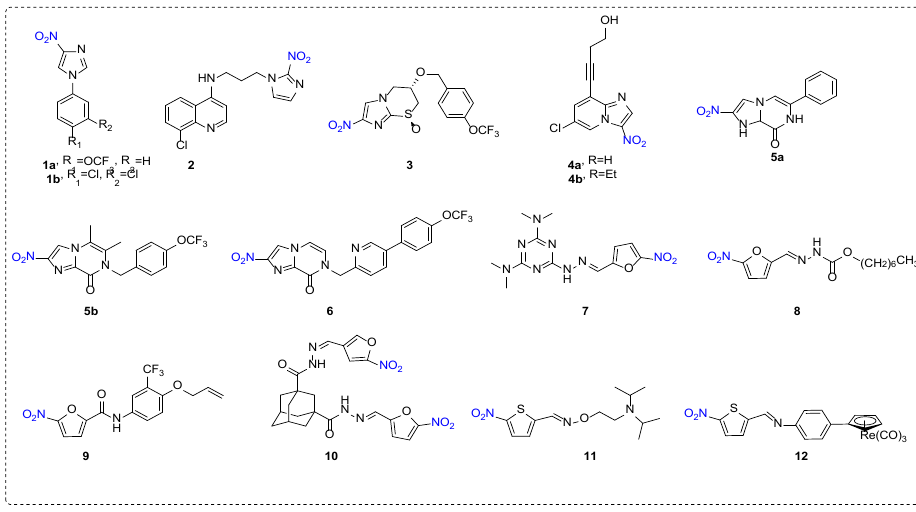
Figure 2. Nitro-containing compounds with antitrypanosomal activity against T. brucei .